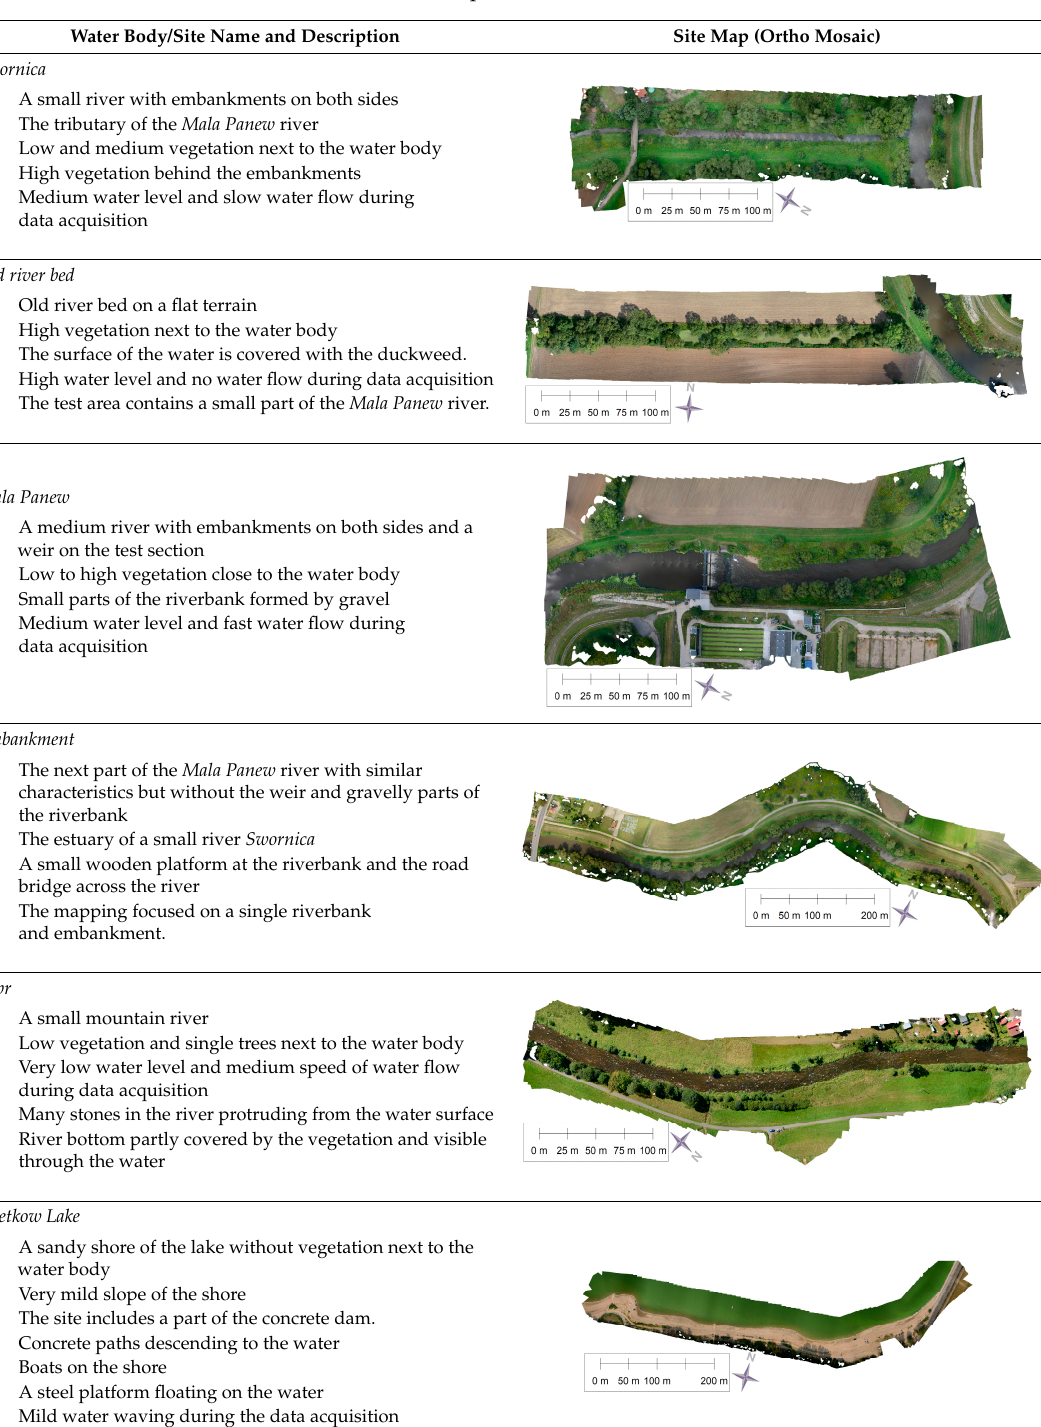
Table 1. Descriptions of the test sites.